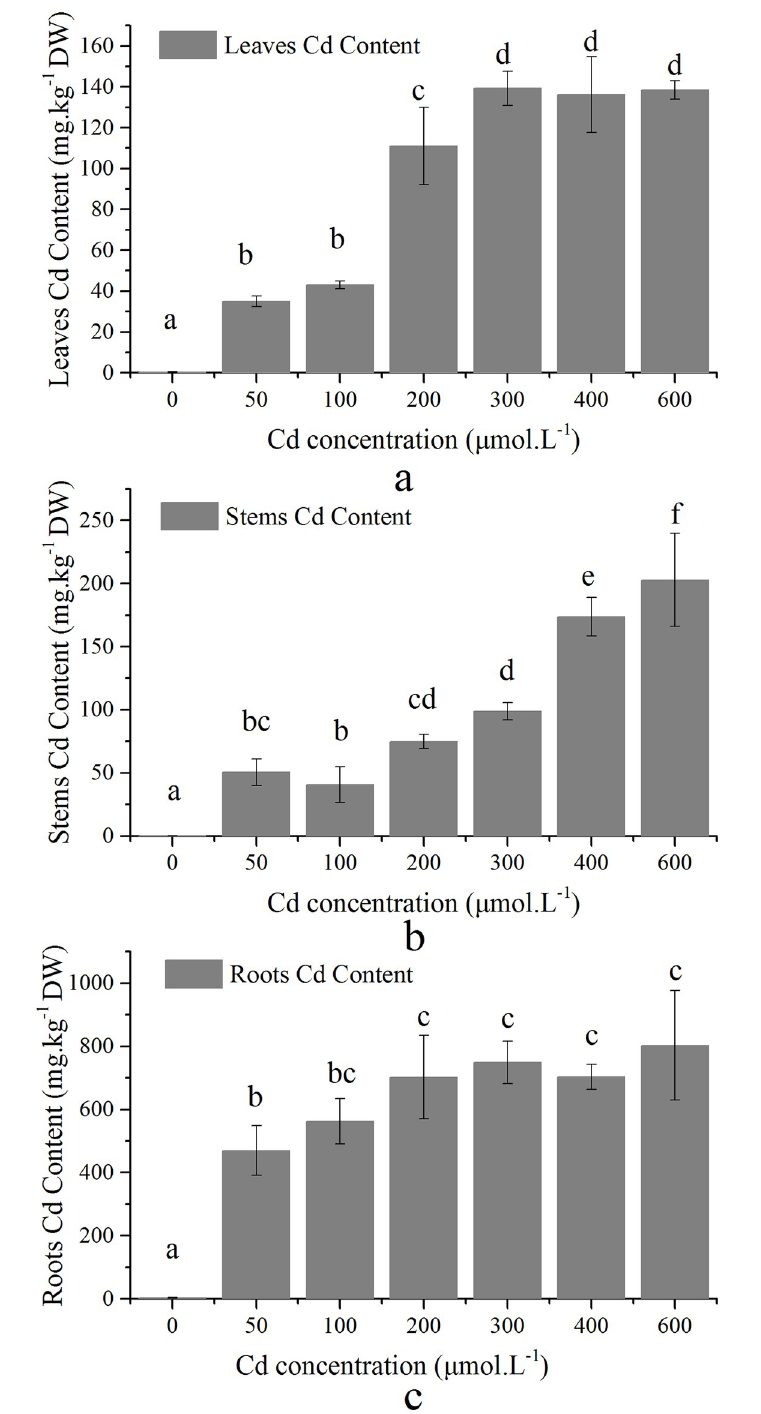
Fig 2. Variations of Cd concentrations in S . portulacastrum (a: Leaves; b: Stems; c: Roots).